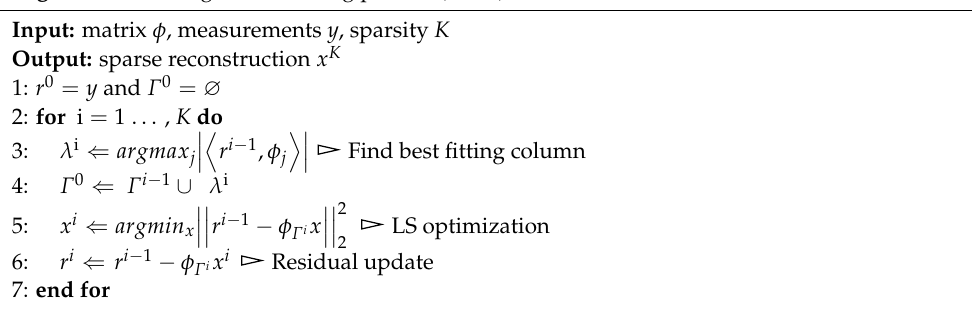
Algorithm 1 Orthogonal matching pursuit